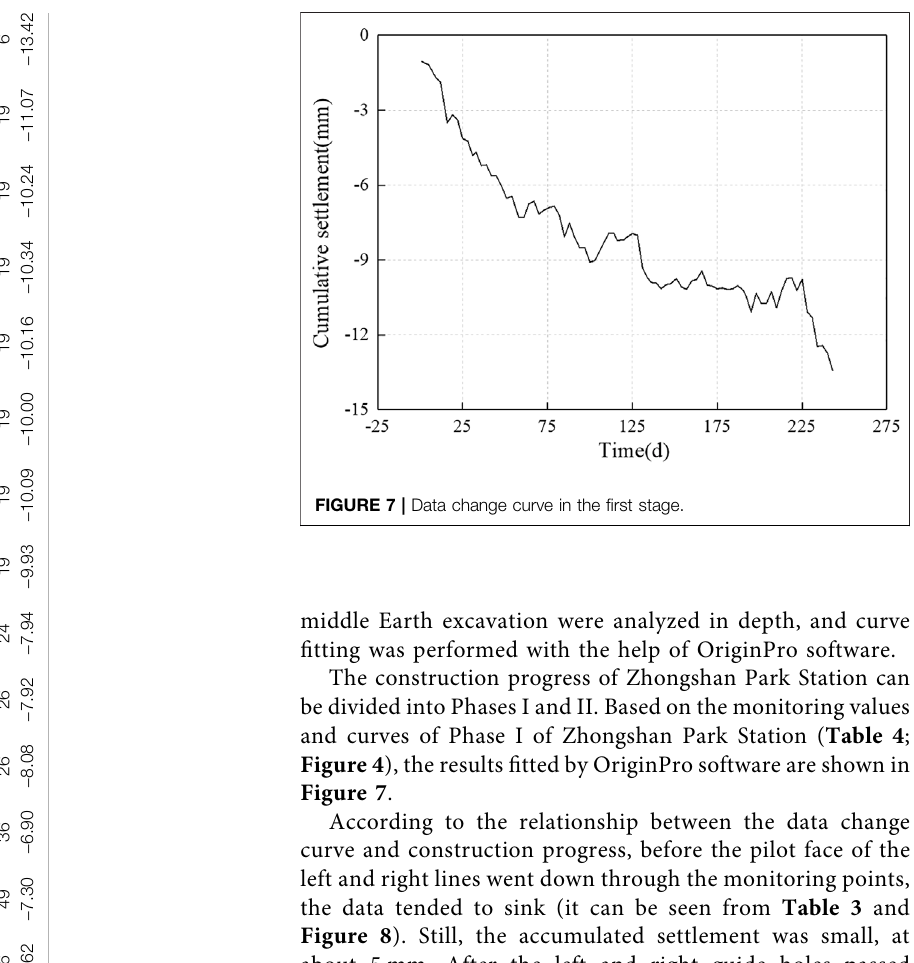
middle Earth excavation were analyzed in depth, and curve fi tting was performed with the help of OriginPro software. The construction progress of Zhongshan Park Station can be divided into Phases I and II. Based on the monitoring values and curves of Phase I of Zhongshan Park Station ( Table 4 ; Figure 4 ), the results fi tted by OriginPro software are shown in Figure 7 . According to the relationship between the data change curve and construction progress, before the pilot face of the left and right lines went down through the monitoring points, the data tended to sink (it can be seen from Table 3 and Figure 8 ). Still, the accumulated settlement was small, at about 5 mm. After the left and right guide holes passed through the measuring points, the surface continued to sink. It was not until the left guide hole passed through the monitoring points for nearly 60 m, that was until the data changes became stable after the tunnel diameter was more than three times (tunnel span is 20 m), and the tunnel depth was six times. In the meantime, the cumulative surface settlement was − 10.09 mm. When the horizontal distance between the pilot face of the middle guide hole and monitoring point was less than 10 m, the settlement trend of the monitoring point started to increase again and entered the second stage. According to the monitoring data in Table 4 , scatter plots are drawn, and curve fi tting is carried out, as shown in Figure 9 . The fi tting formula was correlation, the correlation coef fi cient reached 0.956, near to 1, and the fi tting effect was close to the actual change curve. According to the fi rst stage data processing method, the second stage monitoring data of the monitoring point were fi tted and analyzed, and the curve is shown in Figure 7 . The fi tting formula was B correlation, the correlation coef fi cient reached 0.96 with a T A